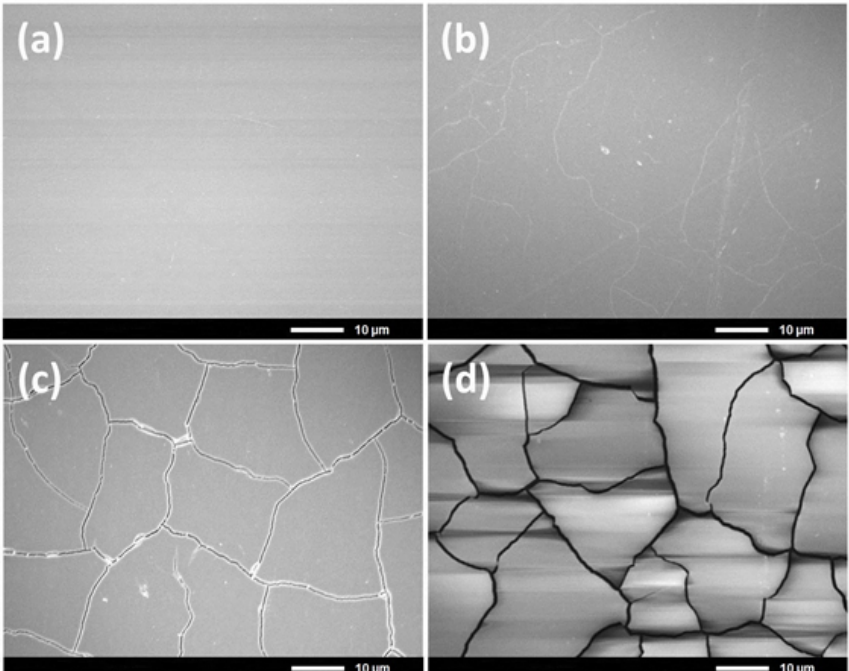
Figure 2. Field Emission Scanning Electron Microscope (FE-SEM) images of the